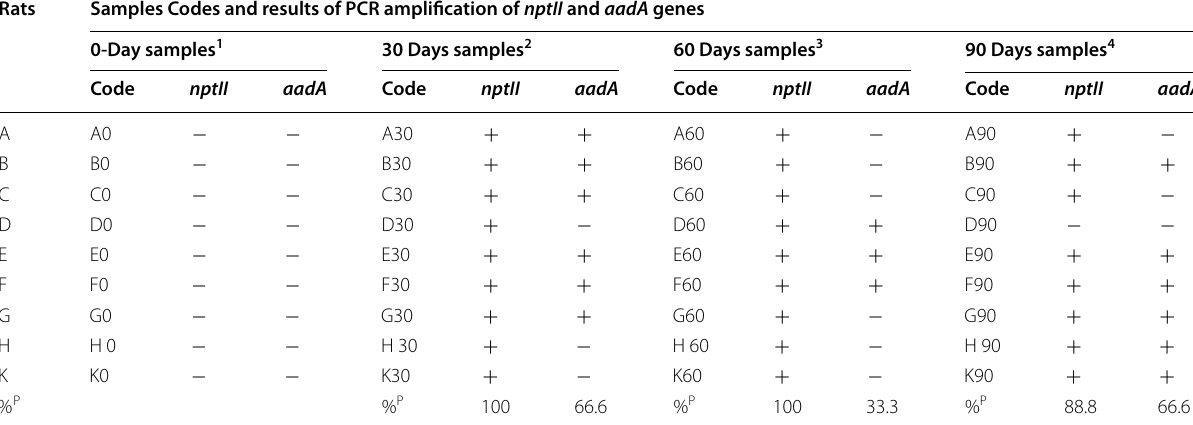
Rats Samples Codes and results of PCR amplification of nptII and aadA genes